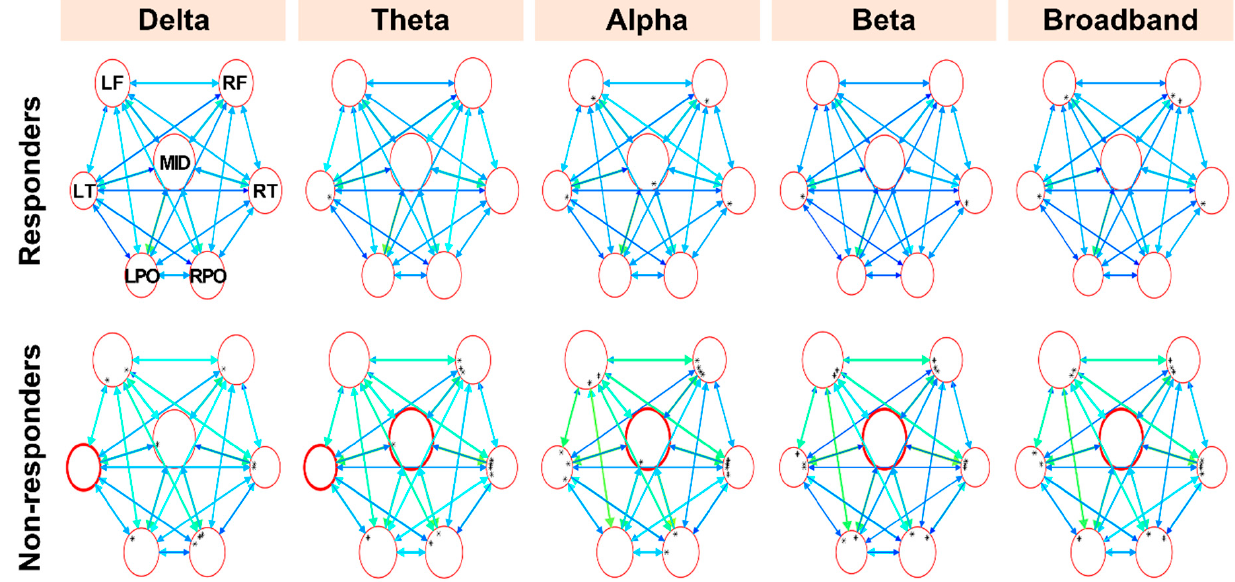
Figure 2. Presurgical outflow connectivity analysis of the responder and nonresponder groups com- pared with the control. The thickened circles represent nodes with a significantly greater connectivity from the node compared with those of the control. LF—left frontal; RF—right frontal; LT—left temporal; RT—right temporal; LPO—left parieto-occipital; RPO—right parieto-occipital.